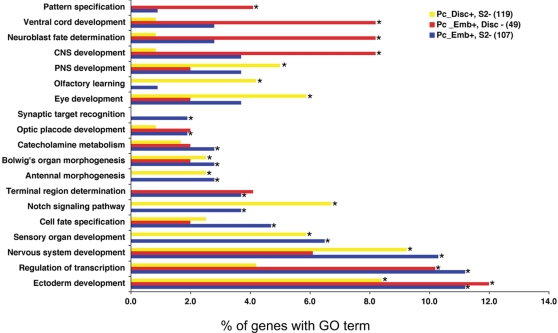
GO analysis on differentially bound Pc targets.“Pc_Disc+, S2-“ are positive for Pc binding in T3 discs but negative in S2 cells. “Pc_Emb+, Disc –“ are positive for Pc binding in embryos but negative in T3 imaginal discs. “Pc_emb+, S2-“ are positive for Pc binding in embryos but negative in S2 cells. Significantly enriched GO terms (corrected p value <0.05) are indicated with an asterisk. The GO class “regulation of transcription” is plotted; the related GO term “regulation of transcription from RNA polymerase II promoter” is also relevant with 33% of genes with this term in “Pc_Emb+, Disc –“ and 21% in “Pc_emb+, S2-“. The Pc targets that are differentially unoccupied in S2 cells are associated with ectoderm/neural differentiation and the genes selectively unoccupied in T3 discs are associated with early CNS development.